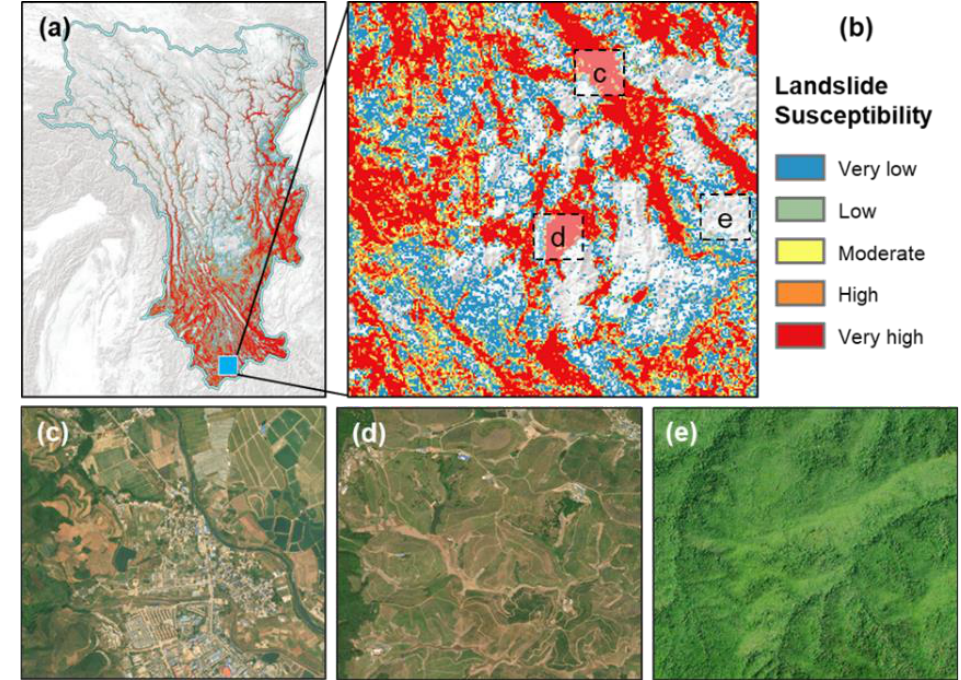
Figure 10. Verification and evidence for LS map over the Hengduan Mountains region. ( a ) The land- slide susceptibility classification; ( b ) landslide susceptibility in the southern part of the area. Panels of ( c – e ) show Esri satellite imagery with different land covers: ( c ) human settlements, ( d ) terrace, and ( e ) forest area.